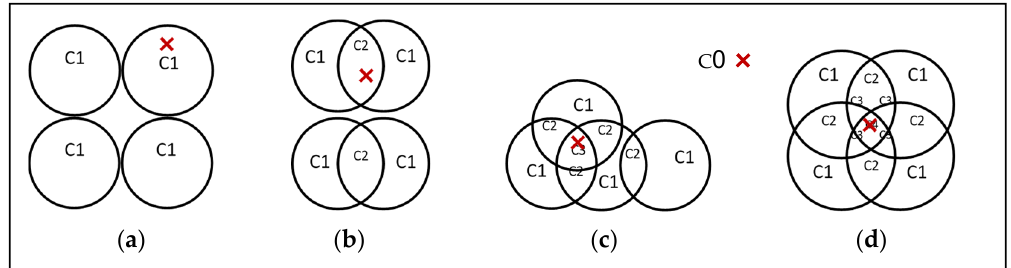
Figure 5. The example of coverage degree, ( a – d ) indicate the covered areas by one, two, three, and four stations.